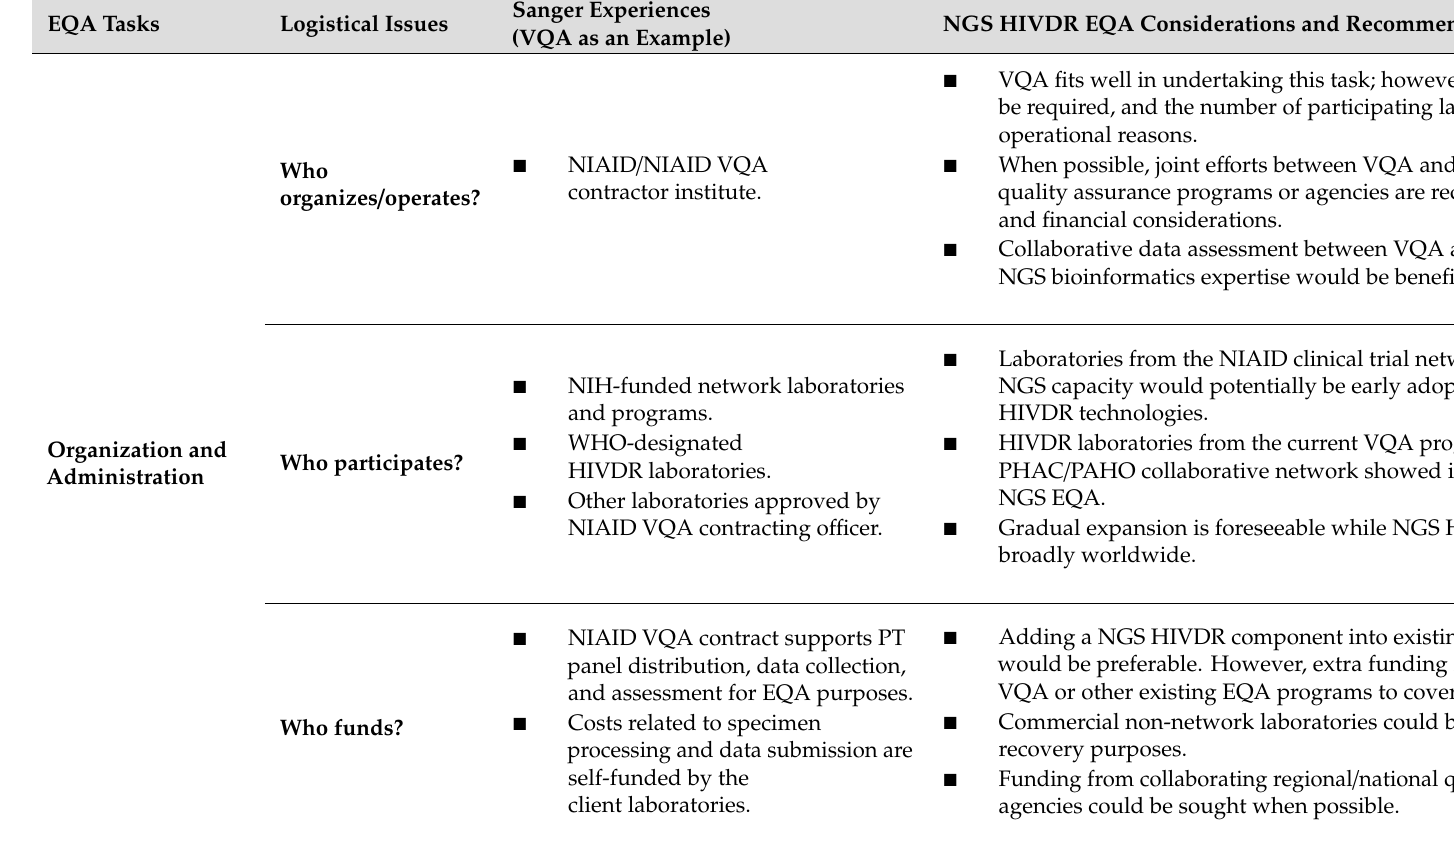
Table 1. NGS EQA for HIV drug resistance testing: logistical challenges and